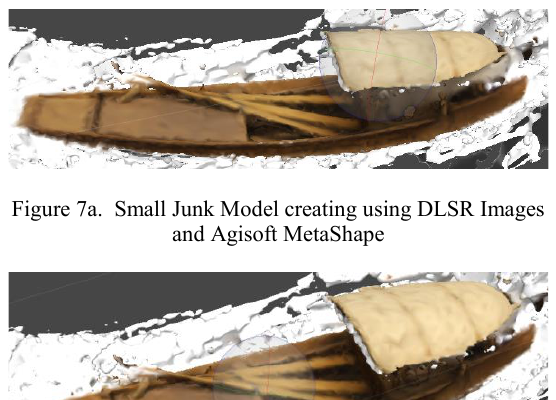
Figure 8. Large Junk with mast /sail and stern overhang outlined in red rectangles.